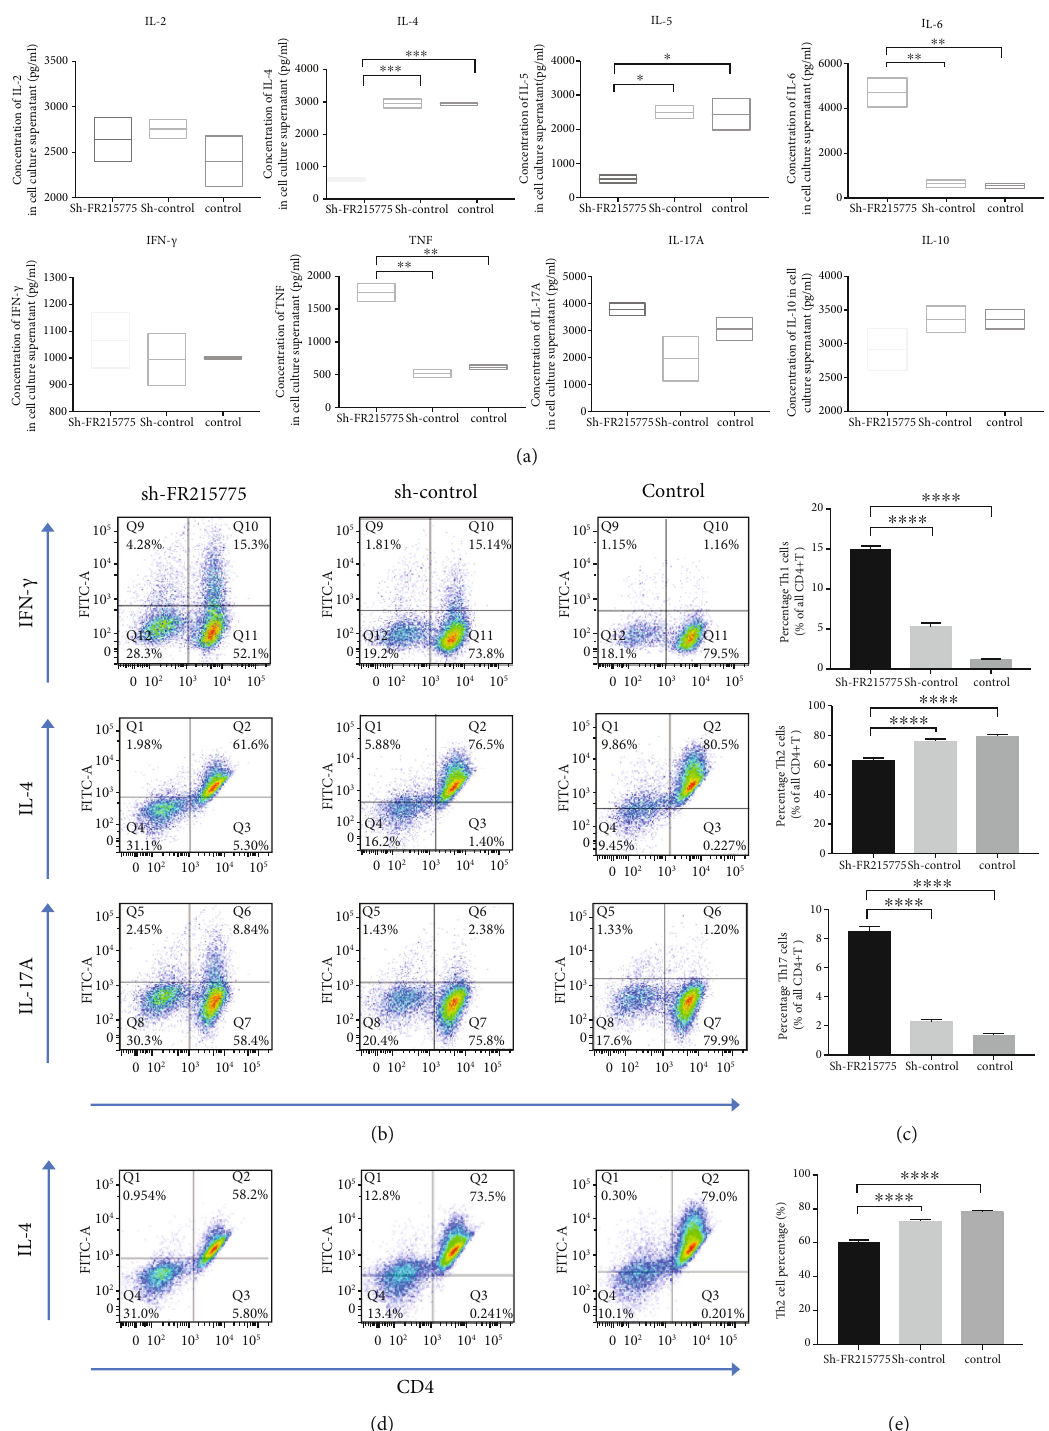
Figure 3: Knockdown of lncRNA FR215775 a ff ect Th2 cell function and di ff erentiation; (a) the concentrations of IL-4 and IL-5 in sh- FR215775 group were signi fi cantly lower than those in the control group; (b, c) the proportion of Th2 cells decreased whereas the proportion of Th1 and Th17 cells increased in the cells of sh-FR215775 group; (d, e) the proportion of induced Th2 cells was signi fi cantly reduced in the sh-FR215775 group; ( ∗ P < 0 : 05 , ∗∗ P < 0 : 01 , ∗∗∗ P < 0 : 001 , ∗∗∗∗ P < 0 : 0001